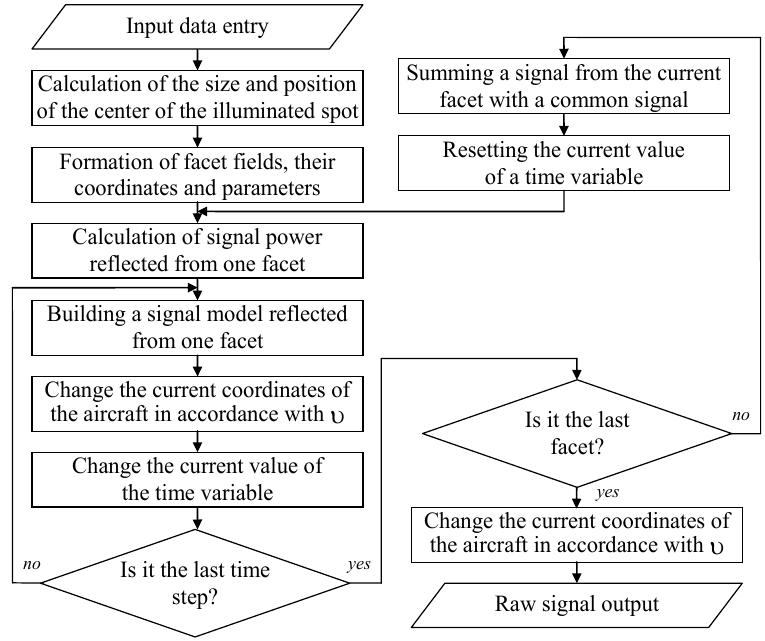
Fig. 3. Algorithm for modeling the raw signal reflected from the